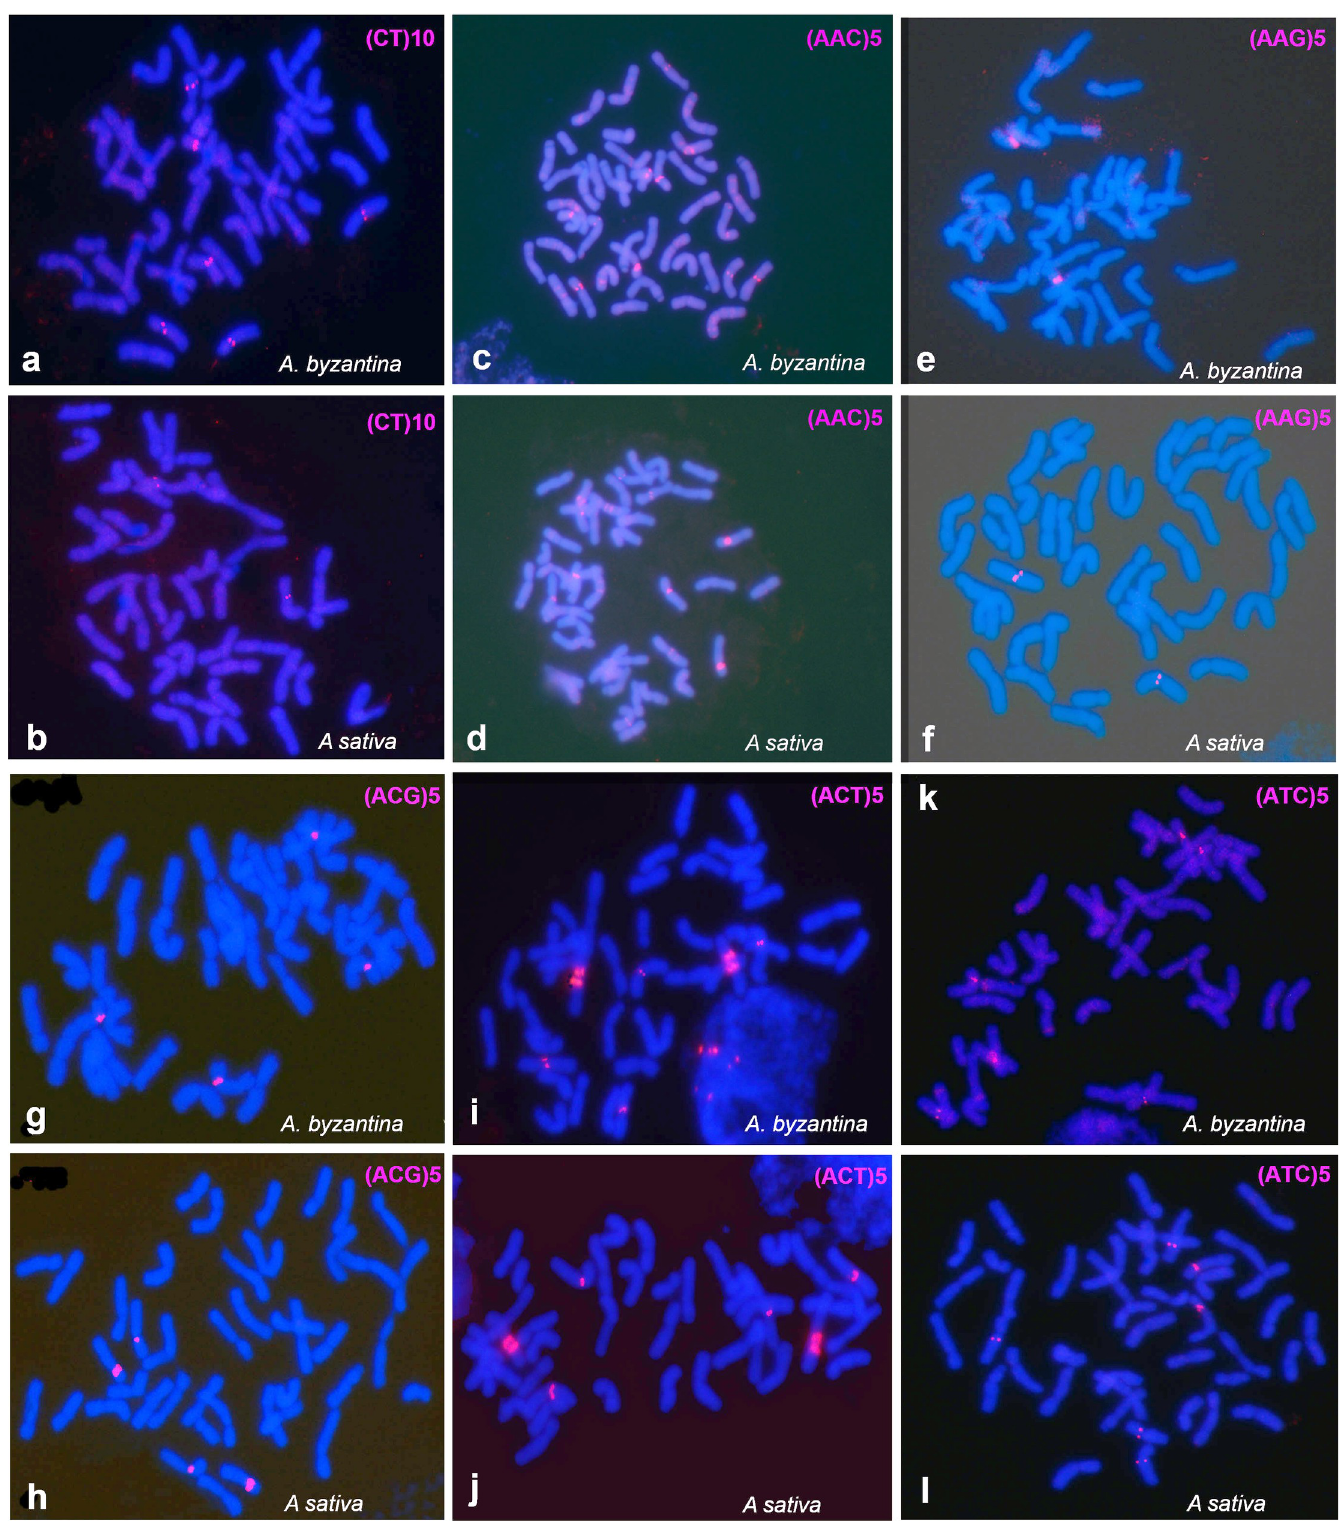
Fig 4. FISH of mitotic metaphases of hexaploid species, A . byzantina y A . sativa , showing the distribution of SSR hybridization signals in red. (a and b) CT. (c and d) ACC. (e and f) AAG. (g and h ACG. (i and j) ACT. (k and l) ATC.